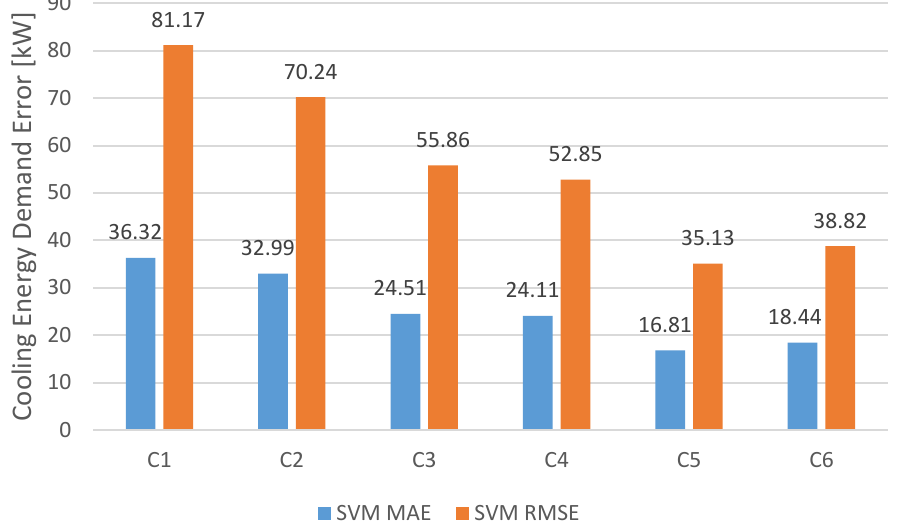
Figure 11. Error metrics for cooling energy demand using SVM.